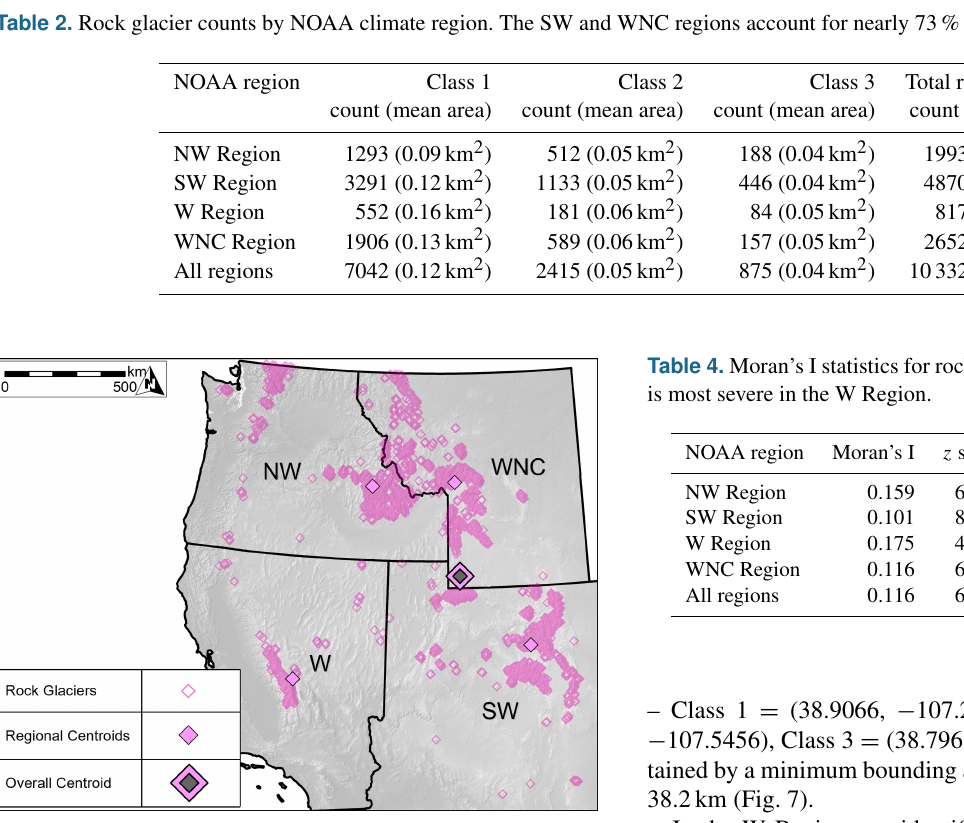
Figure 3. Locations of rock glacier inventory features ( n = 10332), as well as centroids for the entire inventory and NOAA climate region subsets. The largest rock glaciers, as well as highest rock glacier densities, are found in the relatively arid Southern Rocky Mountains. The Sierra Nevada of California and Uinta Mountains of Utah, climatologically similar to the Southern Rockies, also host large rock glaciers at high densities. Rock glaciers of the humid Cascade Mountains are smaller and less densely distributed, and only a few pockets of rock glaciers are found south of 35 ◦ N lat- itude. However, the western United States is generally defined by mountainous, high-elevation terrain, and rock glaciers are found in all 11 western states. Table 3. Moran’s I statistics for rock glacier class. Spatial clustering is most severe in the W Region.